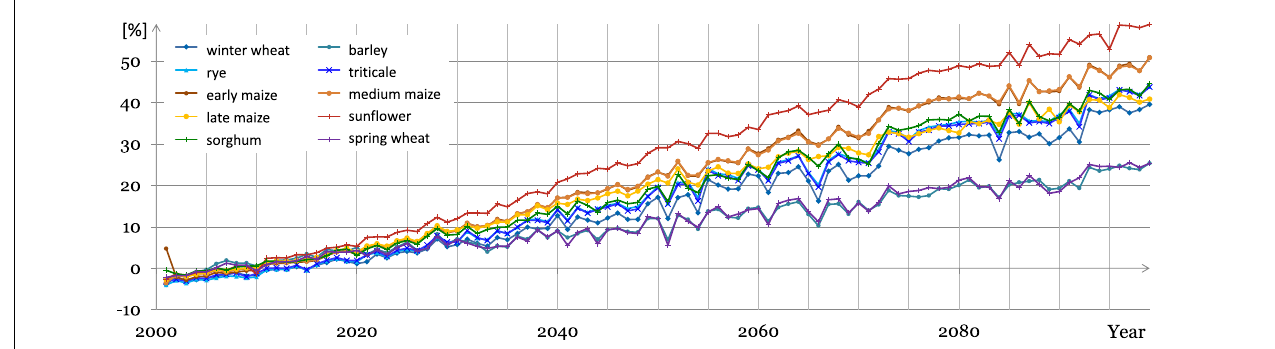
FIGURE 6 | Biomass yield difference between constant and changing [CO 2 ]. A value of + 20% would indicate that biomass yields are 20% higher when modeled using increasing [CO 2 ] instead of fixed